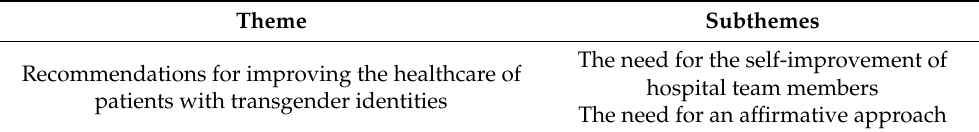
Table 4. Recommendations for improving the healthcare of patients with transgender